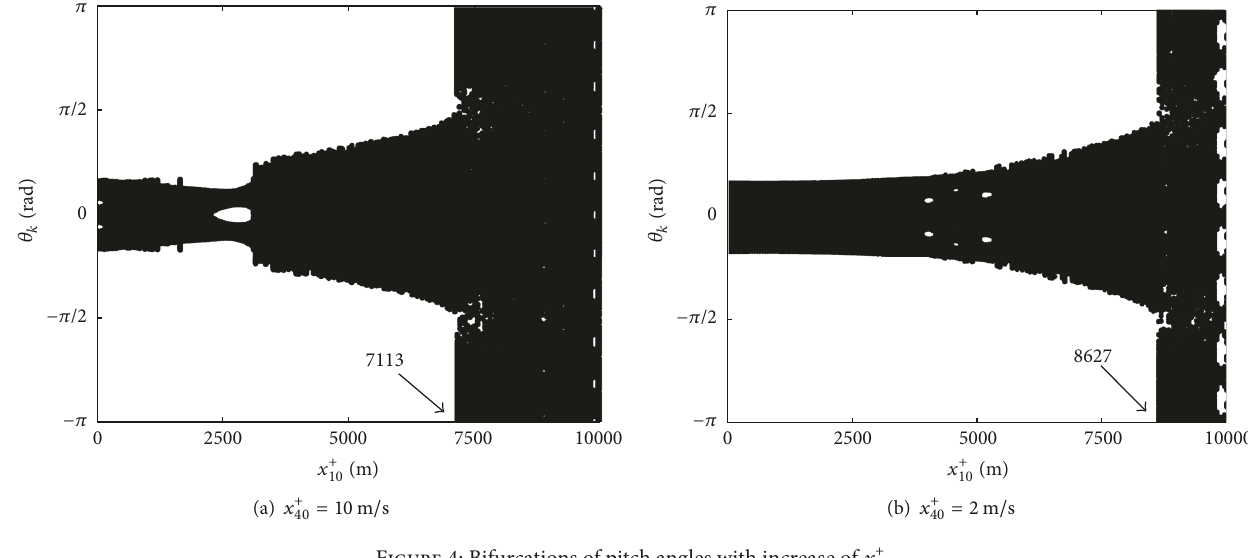
Figure 4: Bifurcations of pitch angles with increase of 𝑥 + 10 .